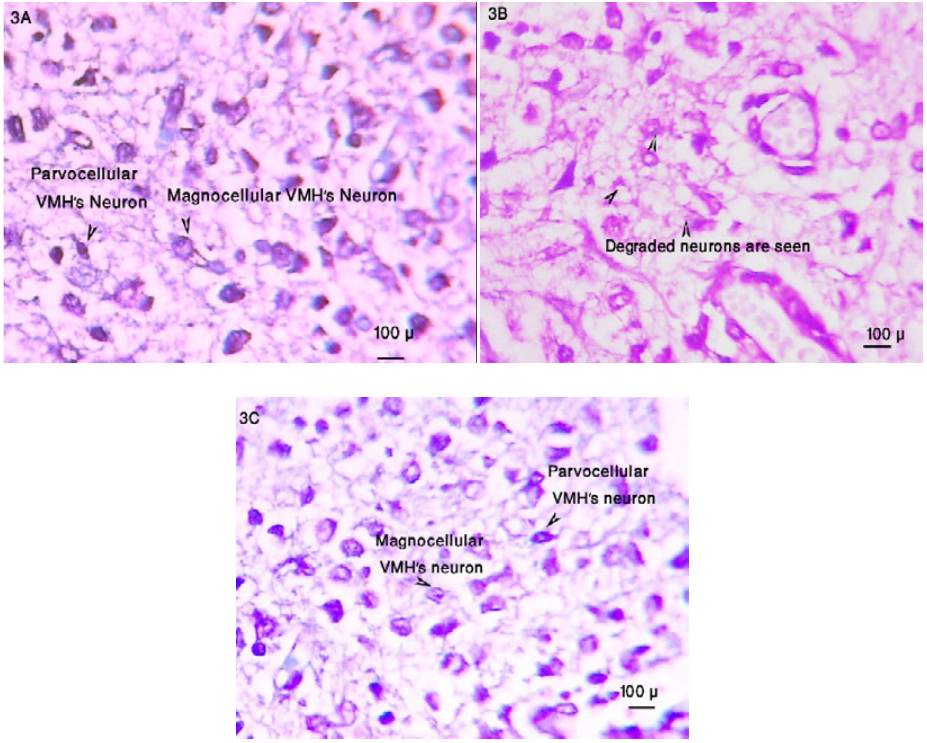
Fig. 3. This figure indicate the VMH’s neurons both in the control saline microinjected (intra-VMH: 3A) and morphine injected groups (3B), and Ag-NPs injected group (3C). Bars beside the samples indicate the values. The arrows and notes further show the preferred